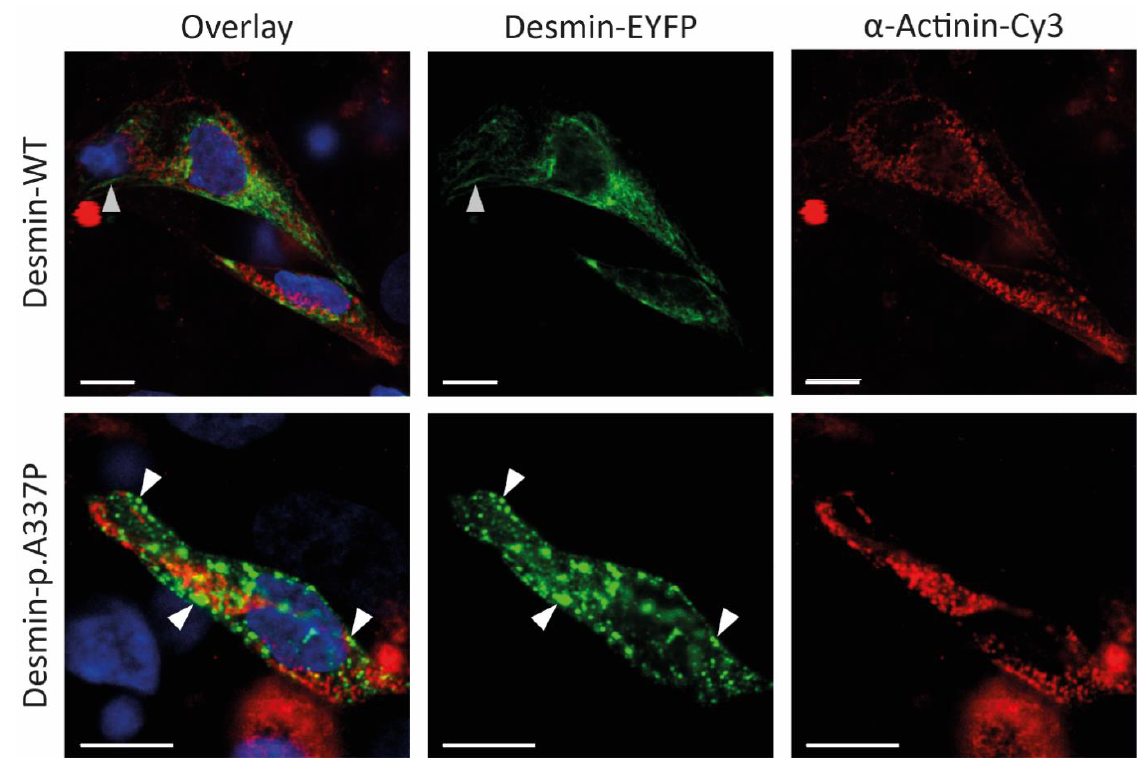
Figure 4. Representative confocal microscopy images of iPSC-derived cardiomyocytes expressing wild-type or mutant desmin (shown in green). The cardiomyocyte marker α-actinin is shown in red and nuclei are shown in blue. Of note, mutant desmin forms cytoplasmic aggregates (white arrows), whereas wild-type desmin forms filamentous structures (grey arrows). Scale bars represent 10 µm.